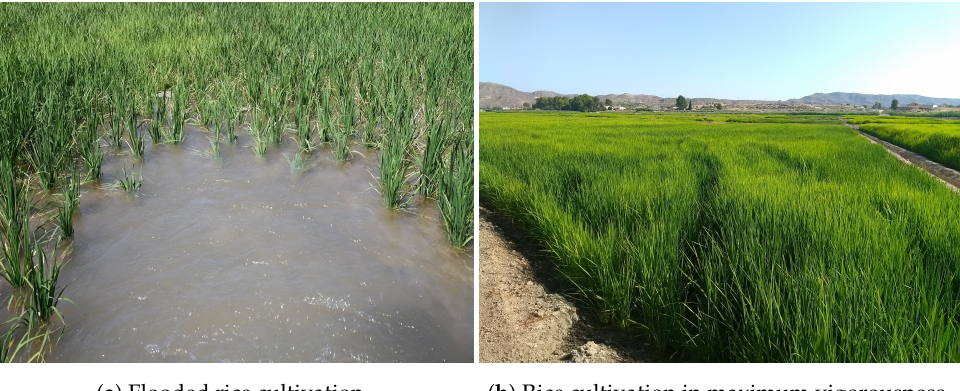
Figure 2. Images of rice cultivation in the Coto Arrocero